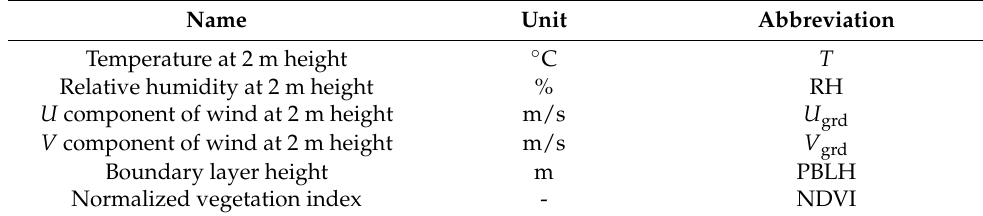
Table 2. Meteorological parameters used in